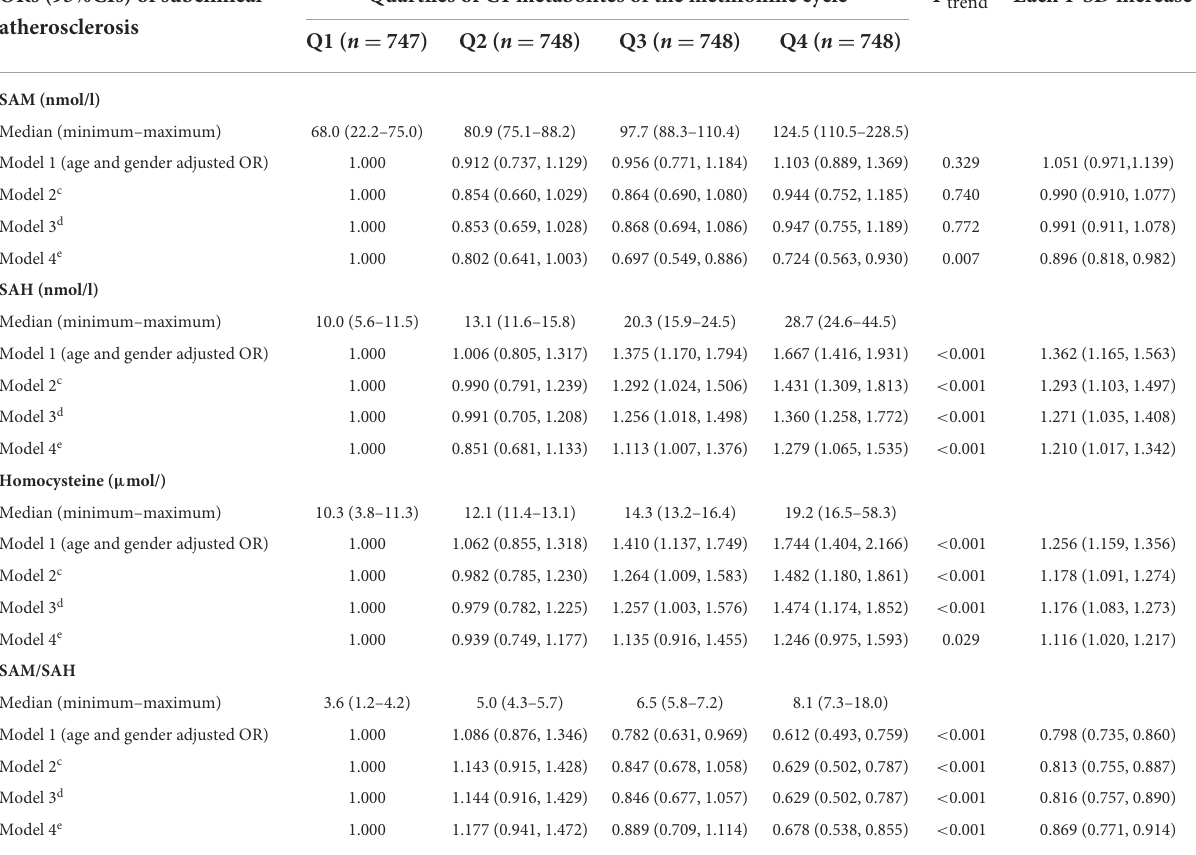
TABLE 2 ORs (95% CIs) for the occurrence of subclinical atherosclerosis by quartiles of SAM, SAH, homocysteine and SAM/SAH levels, Guangzhou Nutrition and Health Cohort ( n = 2991) a . ORs (95%CIs) of subclinical Quartiles of C1 metabolites of the methionine cycle atherosclerosis